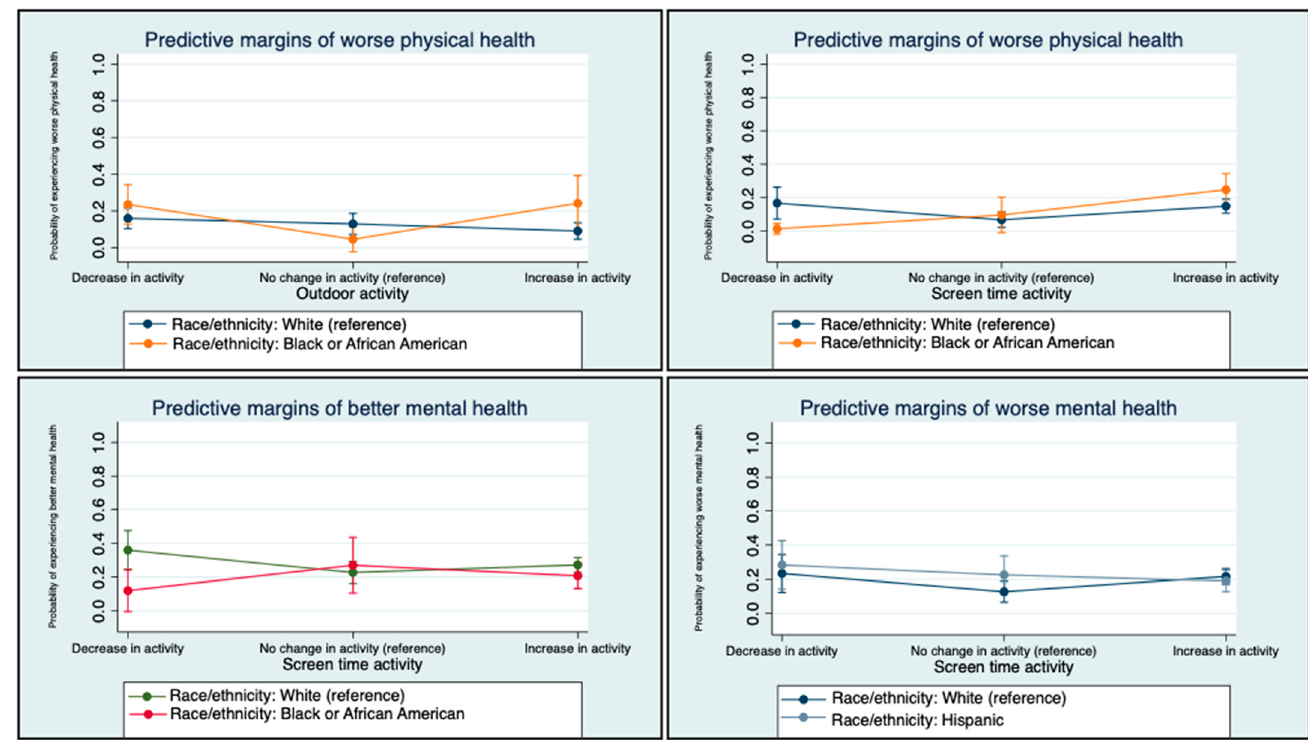
Figure 1. Interaction charts by race/ethnicity .